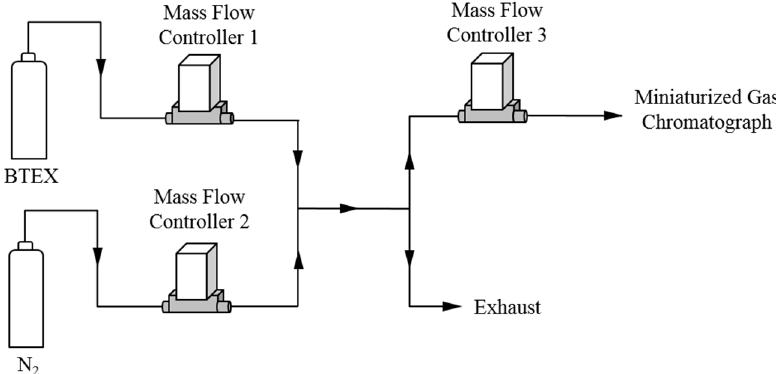
Figure 3. Experimental setup for BTEX generation.